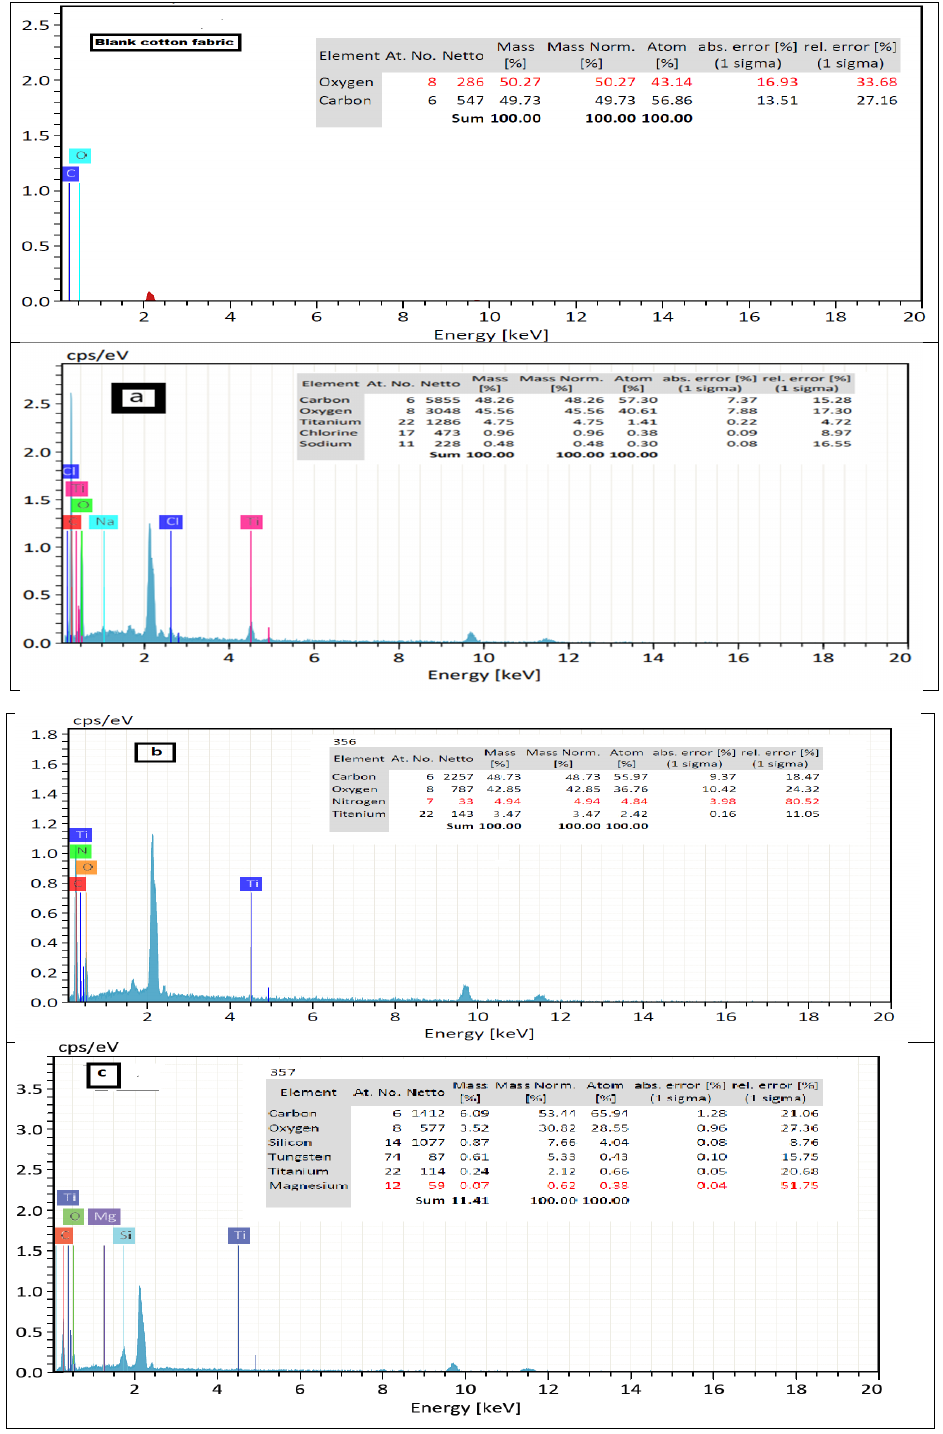
Figure 4. EDX analysis of blank cotton fabric, ( a ) curcumin/TiO 2 –citric-modified cotton fabric, ( b ) curcumin/TiO 2 –Quat 188-modified cotton fabric, and ( c ) curcumin/TiO 2 –GPTMS-modified cotton fabric.